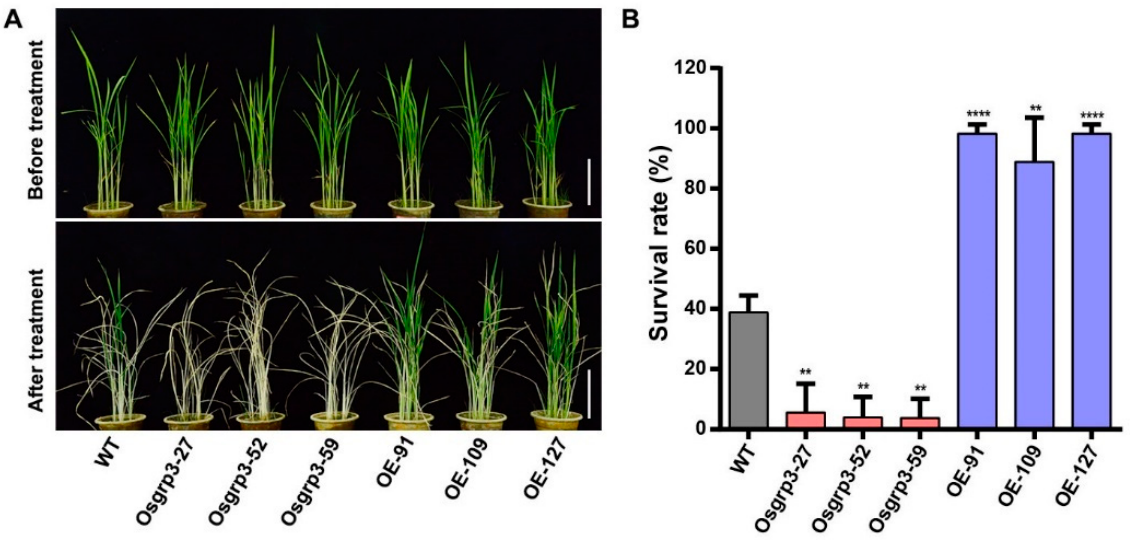
Figure 3. Drought resistance detection of OsGRP3 transgenic materials. ( A ) Phenotypic characteri- zation of knockout lines, OE lines and WT under drought treatment. The scale bars indicate 10 cm. ( B ) Survival rates of the transgenic lines and WT under drought treatment. The significant differences were determined using the Student’s t -test, p < 0.05. **, p < 0.01; ****, p < 0.0001.